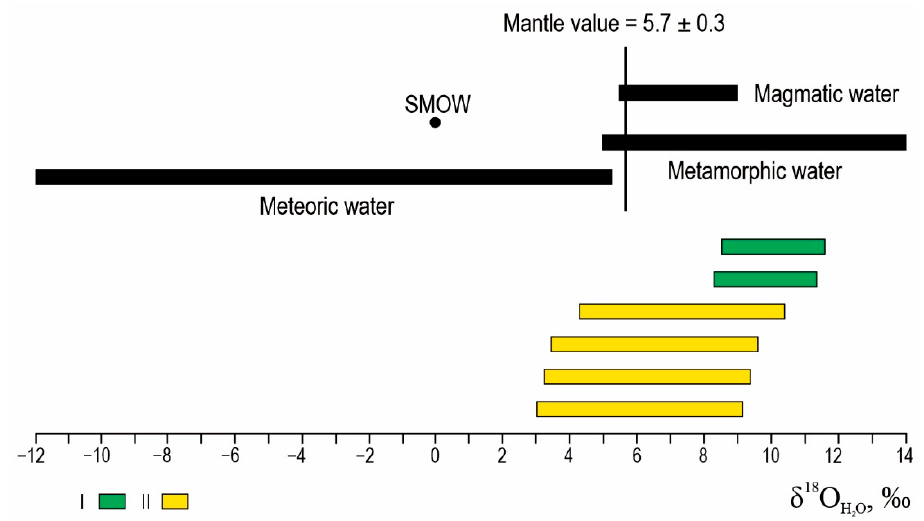
Figure 12. Oxygen isotopic composition of the fluid of I and II ore substages of the Ulug-Sair occurrence.